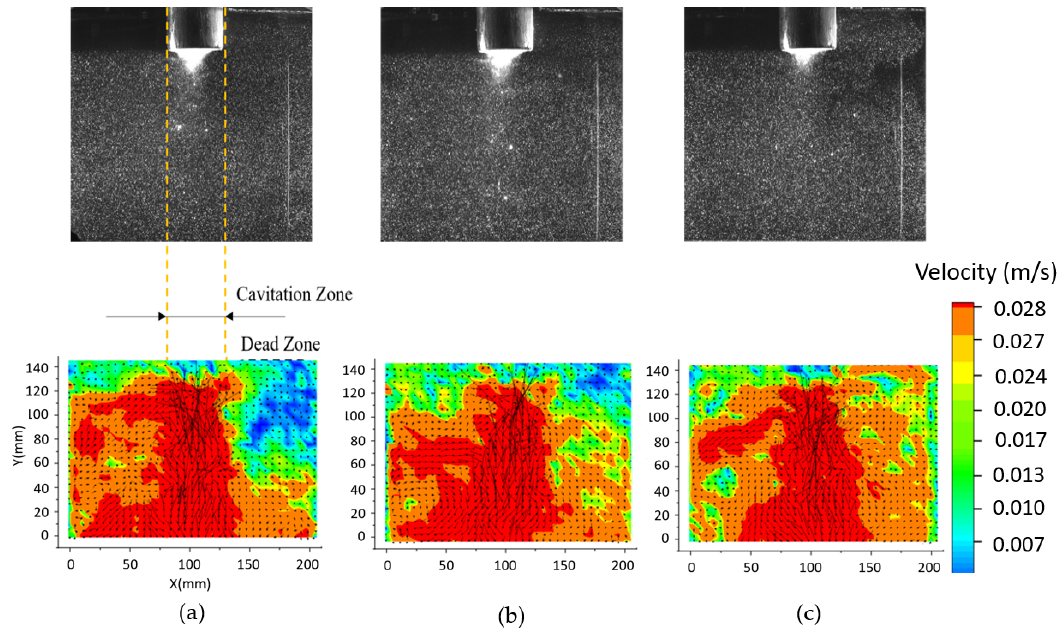
Figure 5. Streaming vectors and average velocity amplitude measured with 2D particle image velocimetry (PIV) below the sonotrode tip at: ( a ) t = 16 ms; ( b ) t = 48 ms; and ( c ) t = 80 ms.